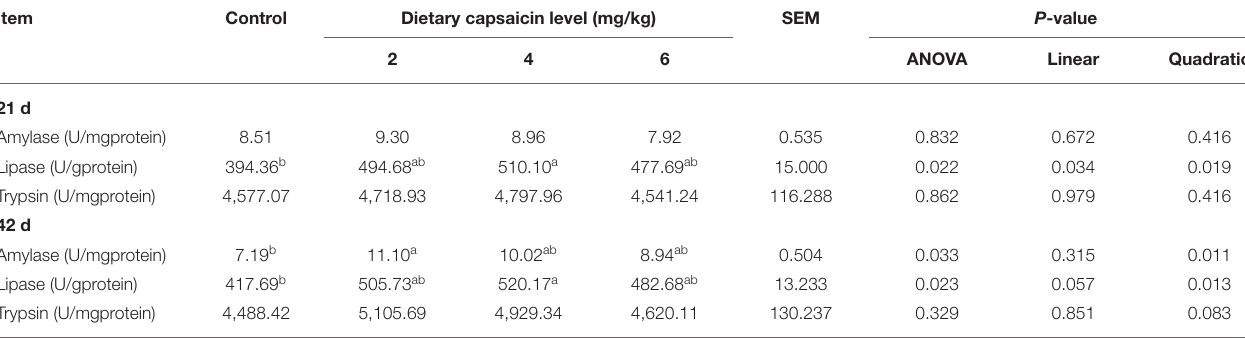
TABLE 6 | Effects of different levels of capsaicin on the digestive enzyme activities of ileal contents of broilers.